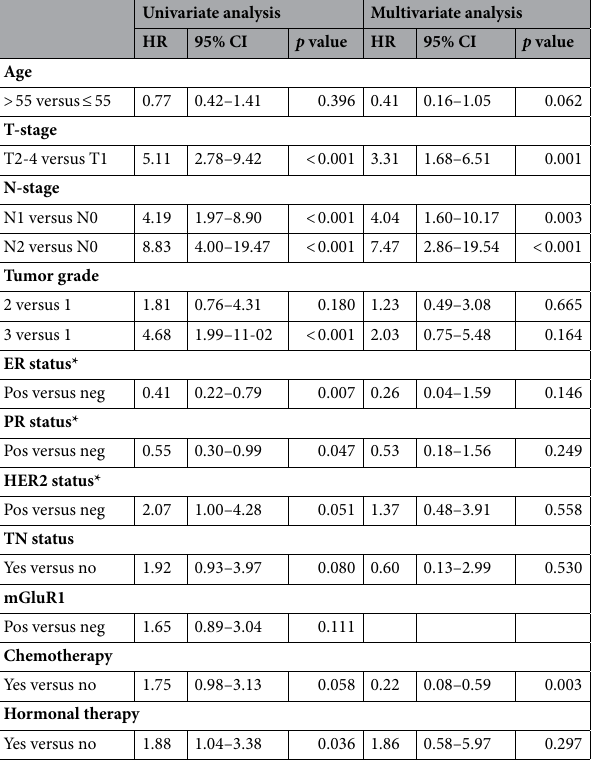
Table 2. Univariate and multivariate analysis of MFS in the entire cohort. *As retrieved from TMA. mGluR1 was not added in the multivariate base model with known prognostic markers because no significance was achieved in univariate regression analysis.